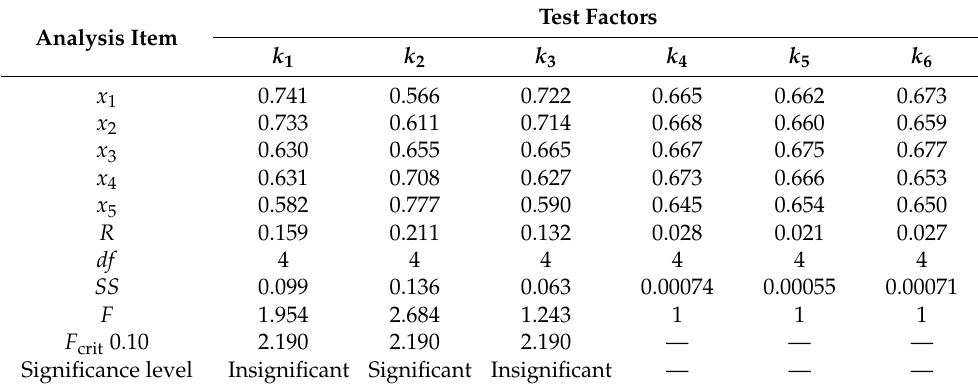
Table 6. Range and variance analysis of factors in a wet road state.